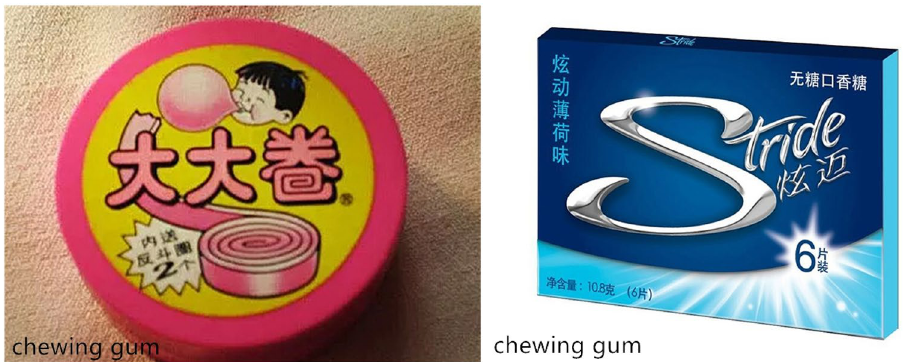
Figure 2. Examples of stimuli (i.e., chewing gum): nostalgia (left) and control (right). The left object depicts the popular chewing gum from childhood; the right object depicts the contemporary popular chewing gum.